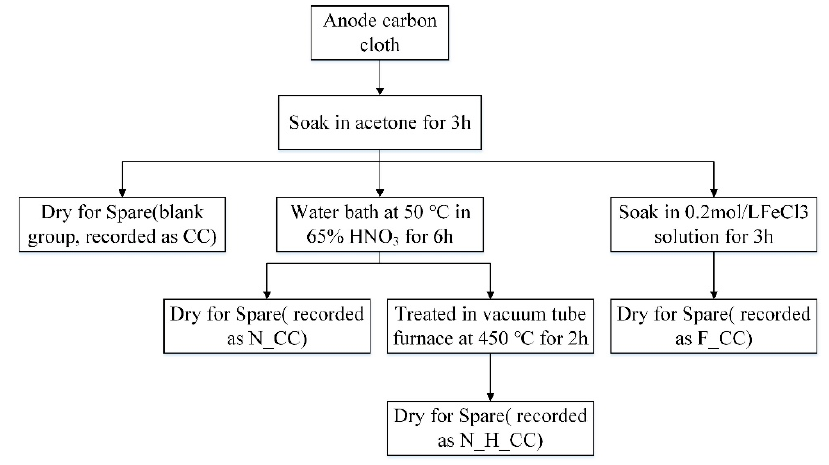
Figure 1. Anode modification roadmap.